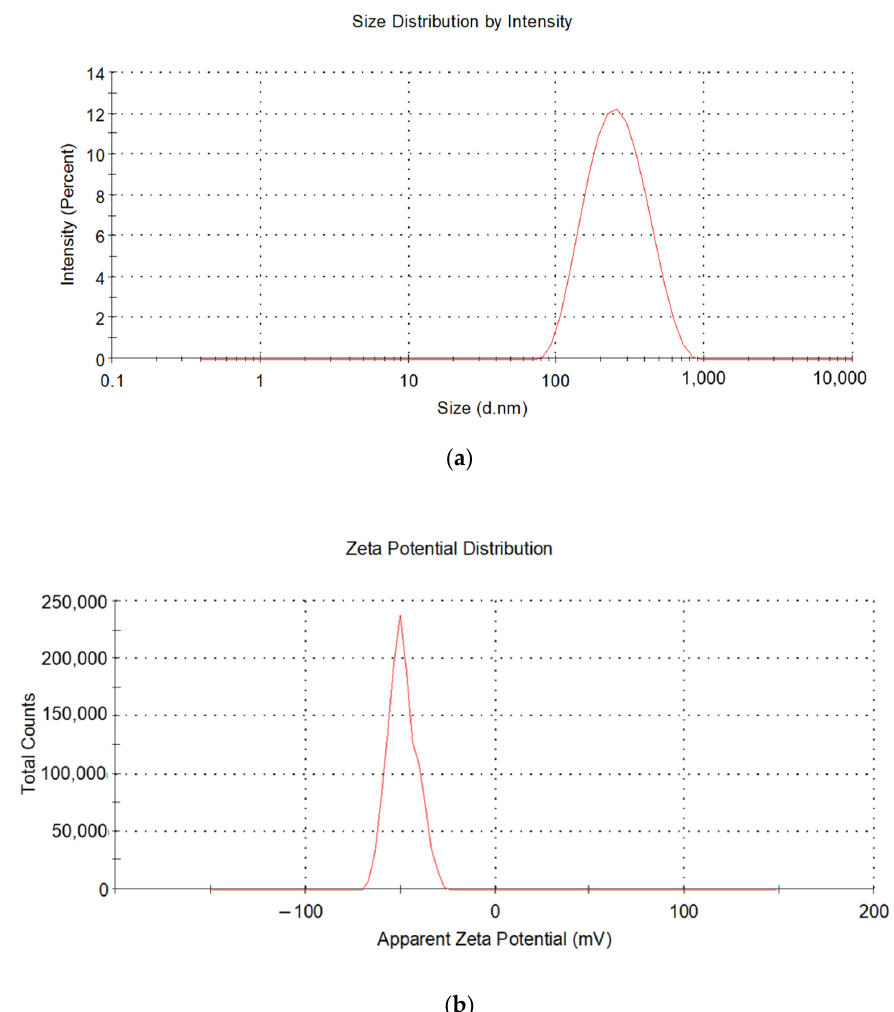
Figure 1. ( a ) Size and ( b ) ζ -potential distribution obtained by dynamic and electrophoretic light scattering, respectively.